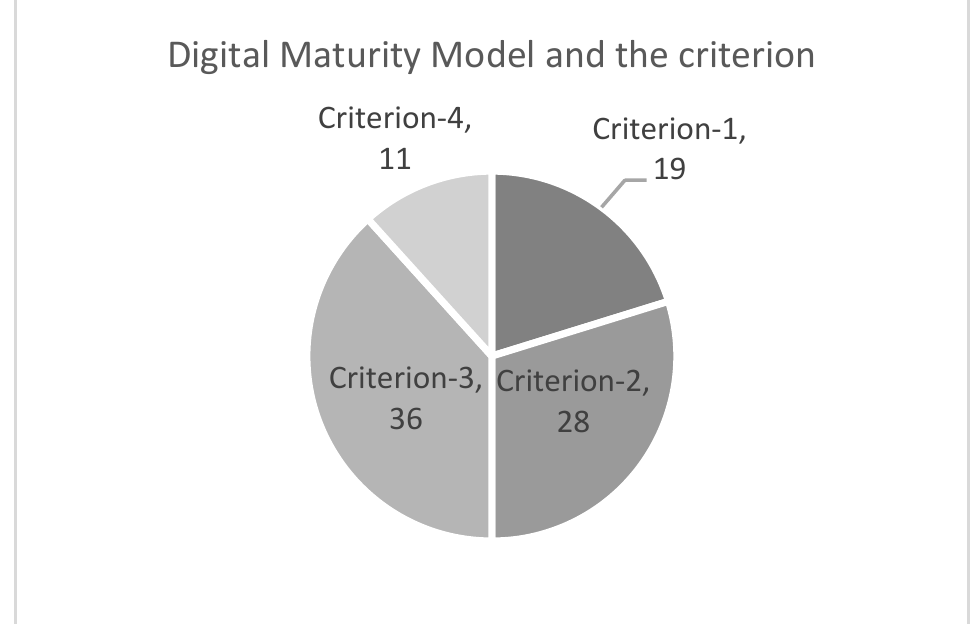
Figure 2. Digital Maturity Model and the criterion.